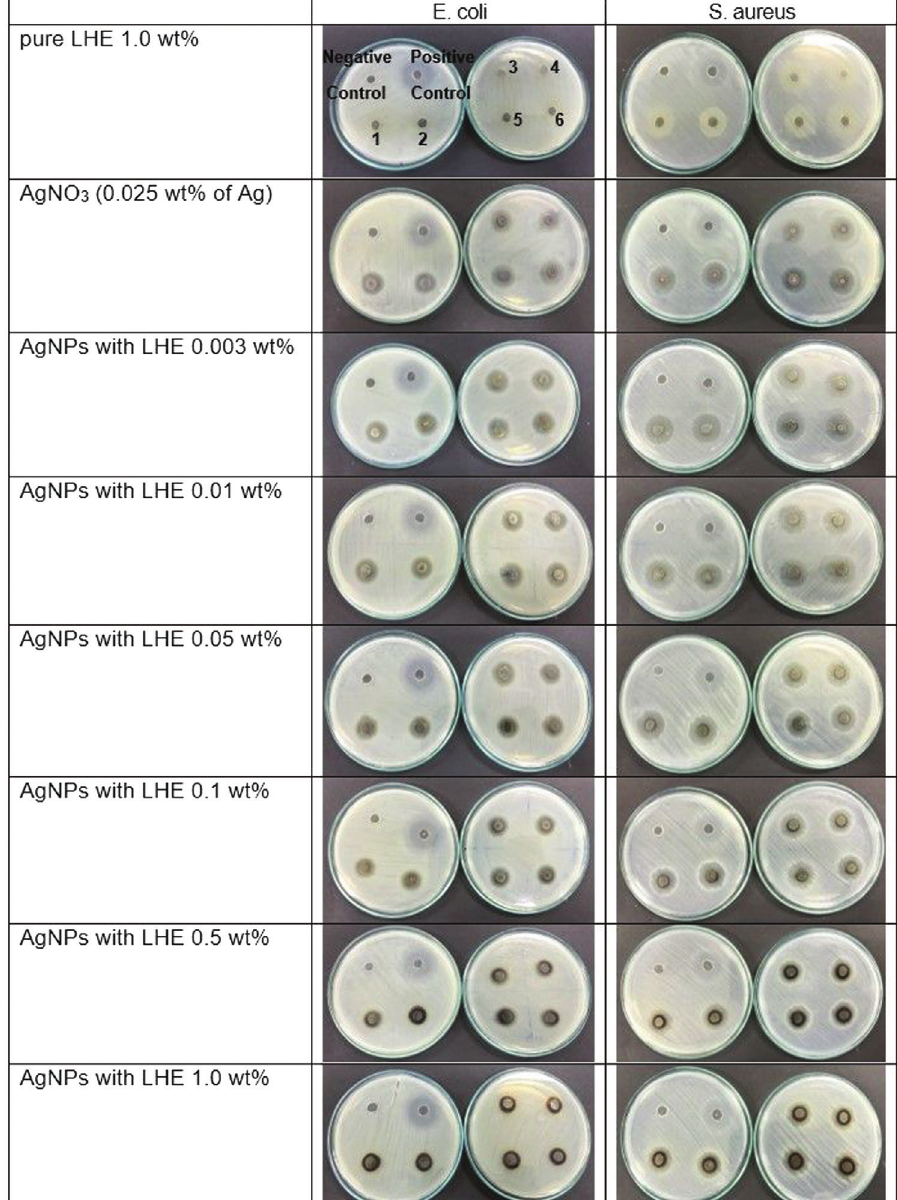
Figure 9: The inhibition zone of negative and positive control (labelled by negative control and positive control) comparing with the inhibition zone of pure LHE, AgNO and AgNPs at the different LHE concentrations (labelled with numbers 1 to 6). The labels are applied to 3 all figures in every condition for both E. coli and S. aureus